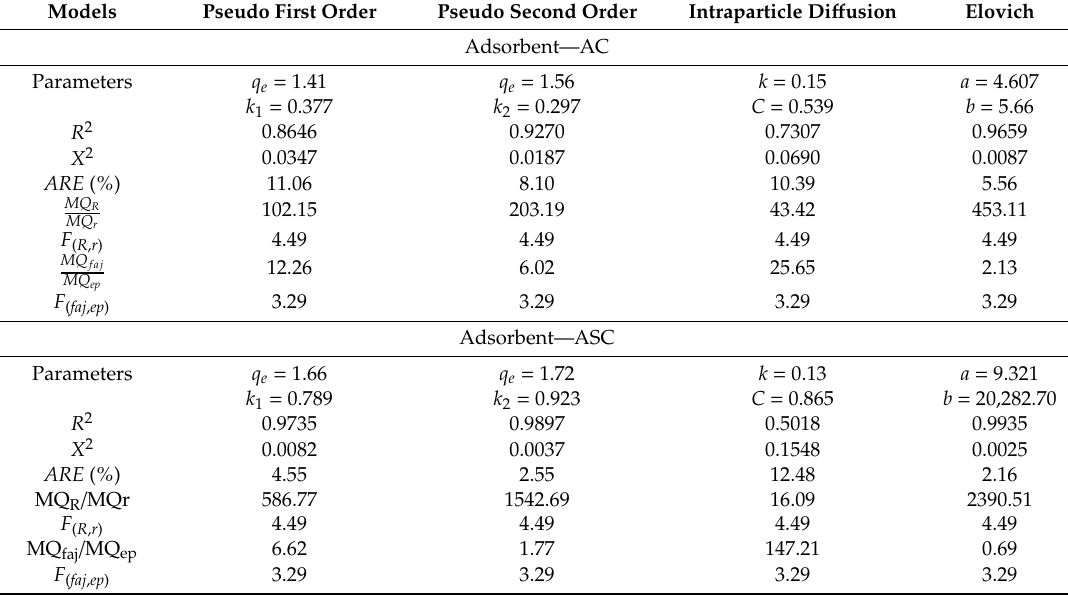
Table 2. Kinetic parameters of methylene blue (MB) textile dye adsorption onto AC and ASC.